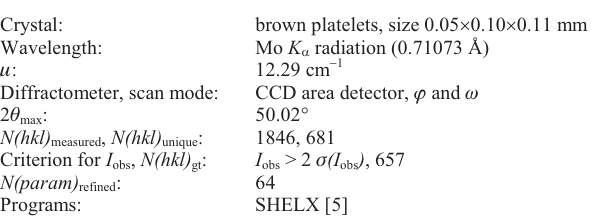
Table 1. Data collection and handling.